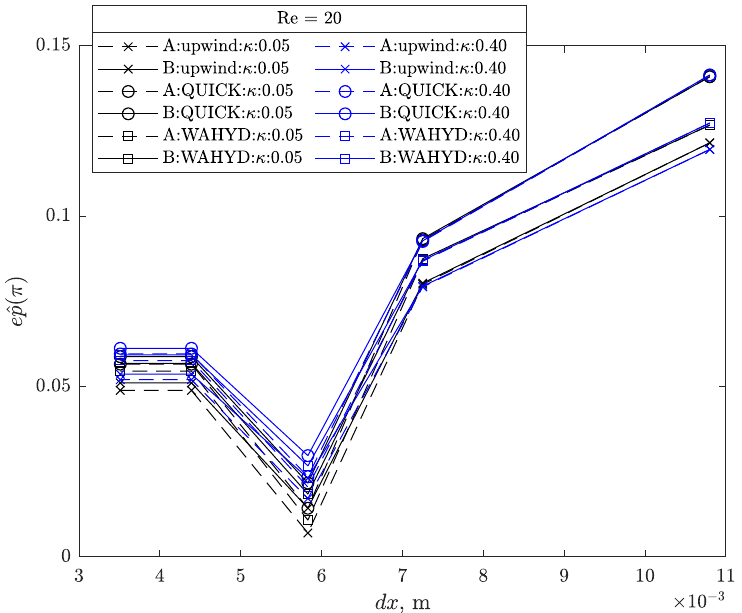
Figure 30. Dimensionless pressure error at θ = π as function of grid size for the flow around a cylinder case with Re = 20.